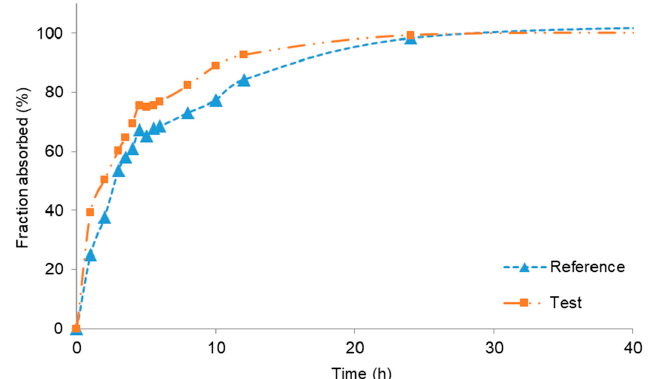
Figure 3. Bioavailable fractions (usually described as Fractions absorbed) obtained by Wagner– Nelson analysis from reference and test formulations.